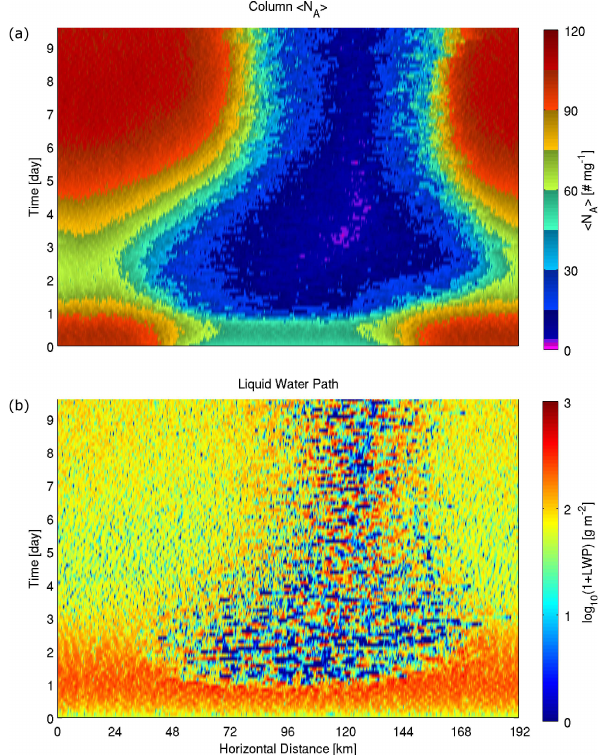
Fig. 14. Hovmöller plots showing evolution of (a) column h N a i and (b) log 10 of 1 + liquid water path in each column. Note that both minimum and maximum column values for LWP occur within the